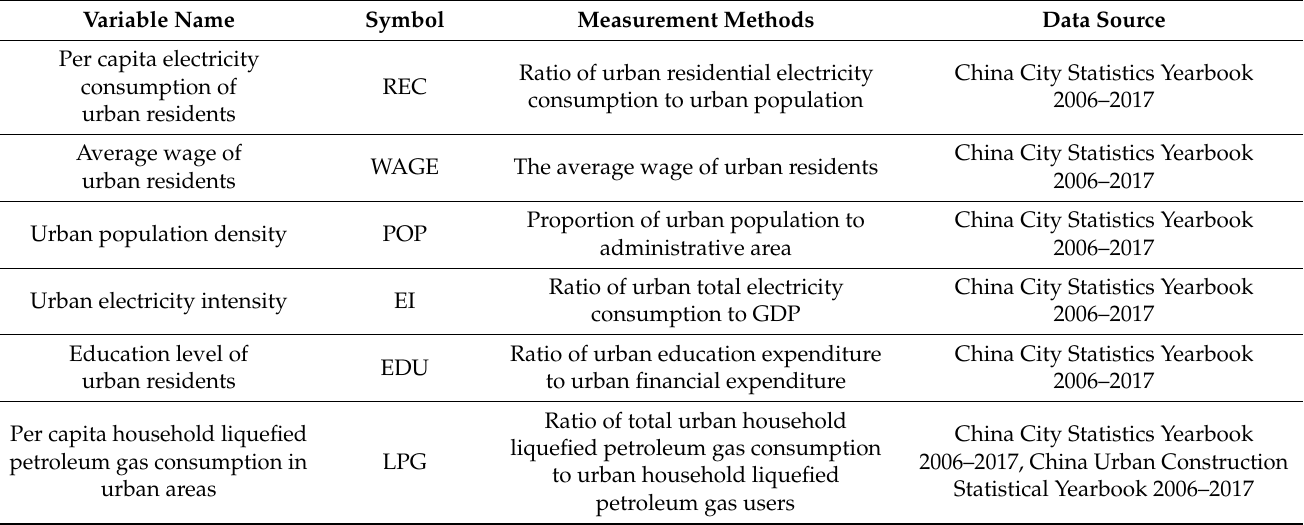
Table 1. Variable description.